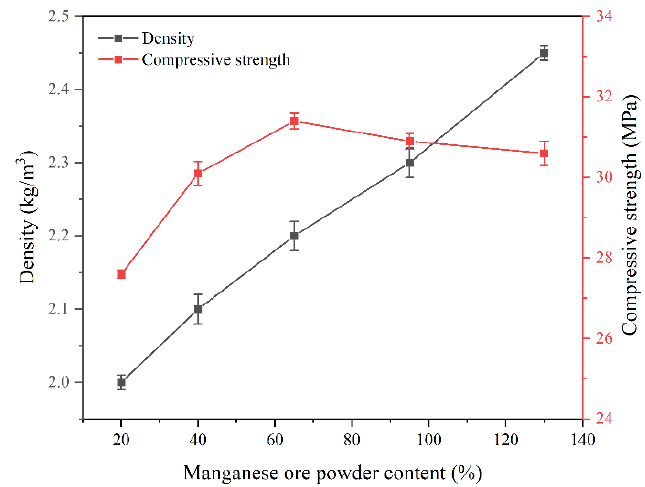
Figure 4. E ff ect of manganese ore powder in the performance of cement slurry.